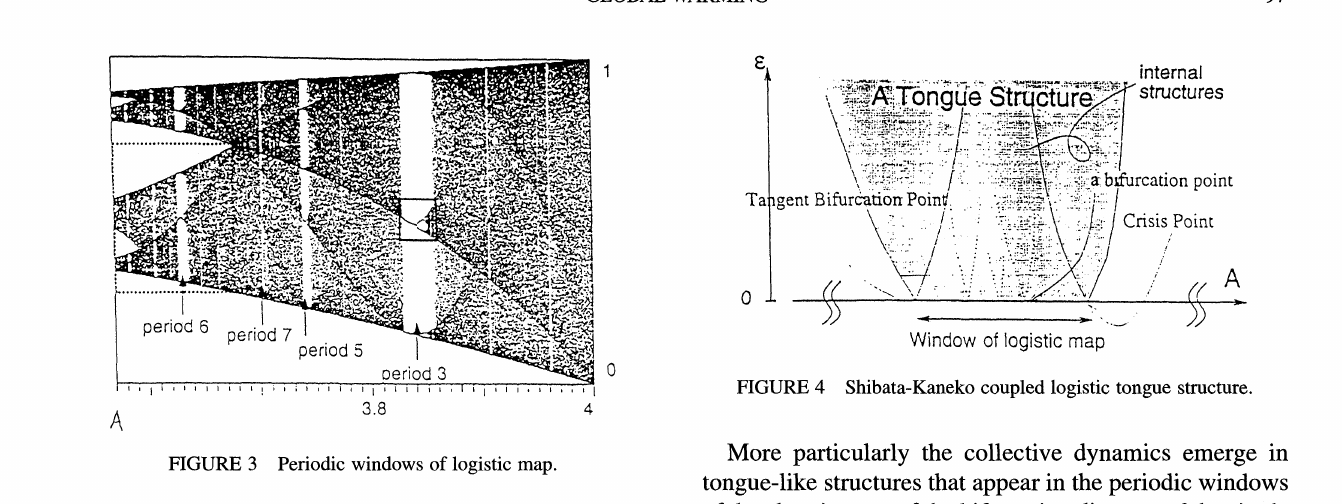
FIGURE 3 Periodic windows of logistic map.